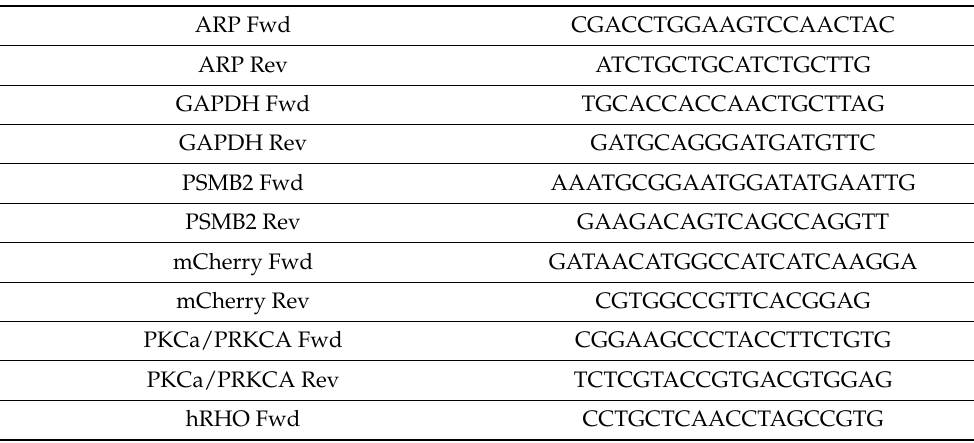
Table 1. List of primers used for